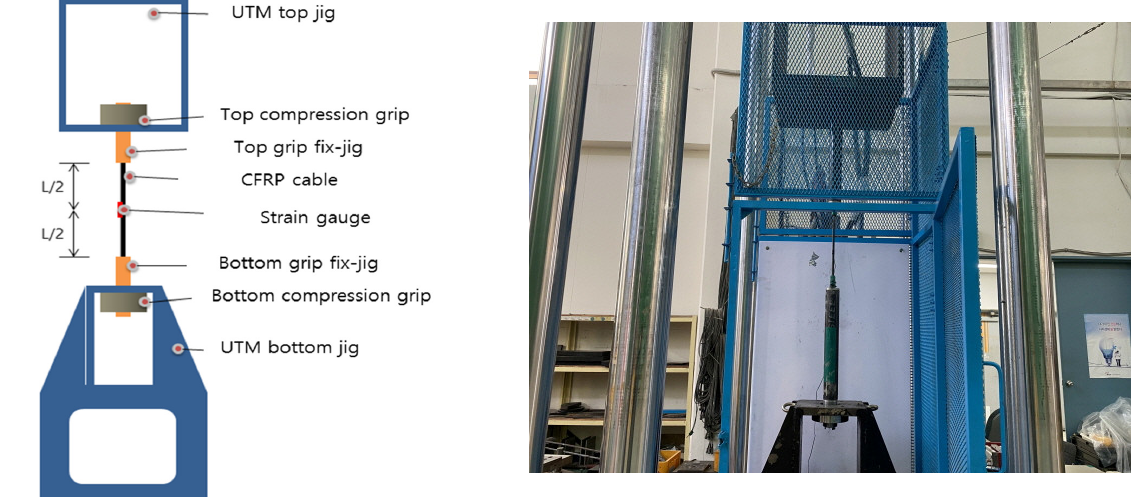
Figure 11. Setup of steel pipe tensile test.